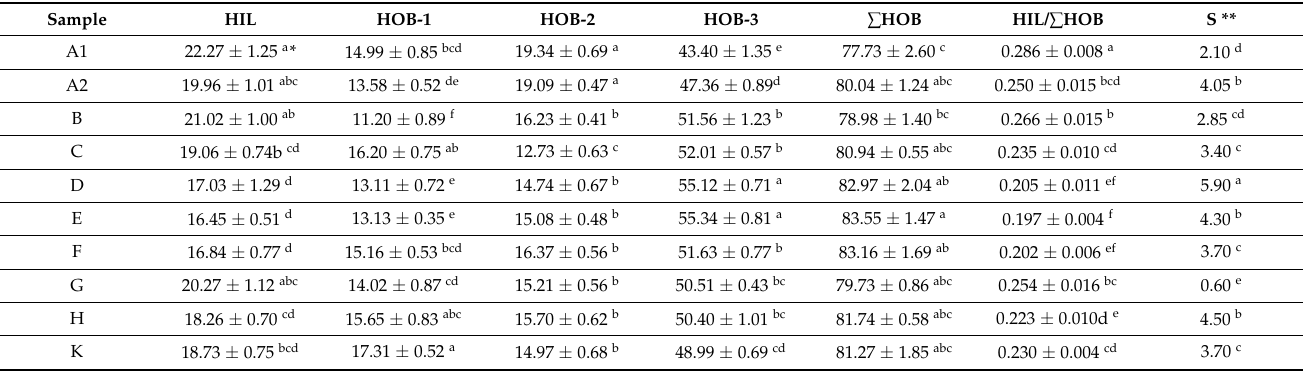
Table 8. Share of hydrophilic (HIL) and hydrophobic (HOB) fraction in humic acids and parameter of EPR.